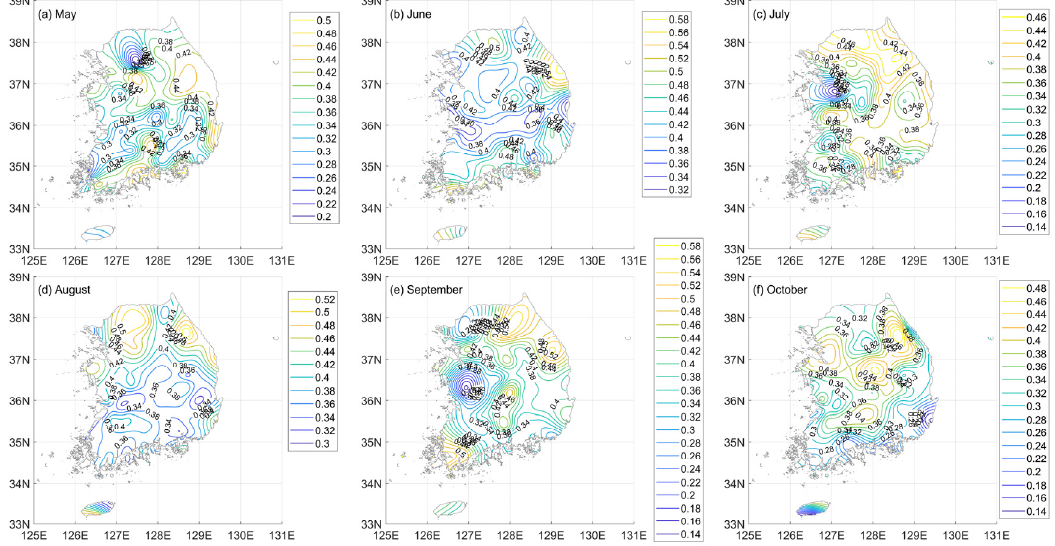
Figure 6. Contour maps of the scaling exponent estimate for the AM series of South Korea on the monthly basis during the rainy season: ( a ) May, ( b ) June, ( c ) July, ( d ) August, ( e ) September, ( f ) October.